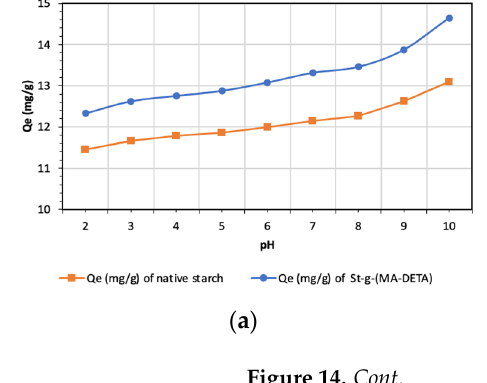
( h ) Figure 14. Adsorption of celestine blue from water at ( a , b ) different pHs ( c , d ) different times ( e , f ) different amounts of bio sorbent and ( g , h ) different initial dye concentrations. 3.6.2. Effect of Contact Time on CB Adsorption The contact time provides useful information about the time taken to reach equilib- rium. The adsorbent–adsorbate contact time was varied (10–1440 min) to determine the maximum CB dye removal percentage at 30 °C and with an initial dye concentration of 15 ppm, as presented in Figure 14c,d. It is observed that the highest adsorption capacity and removal percentage are achieved after 1440 min. The adsorption capacity increased from